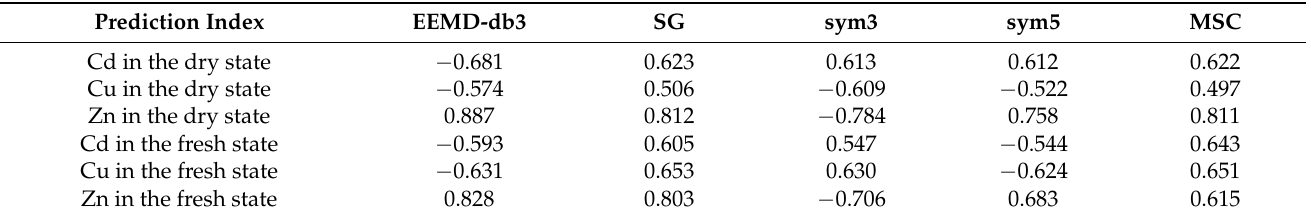
Table 2. The maximum correlation coefficient between the prediction index and variable after different pretreatment.